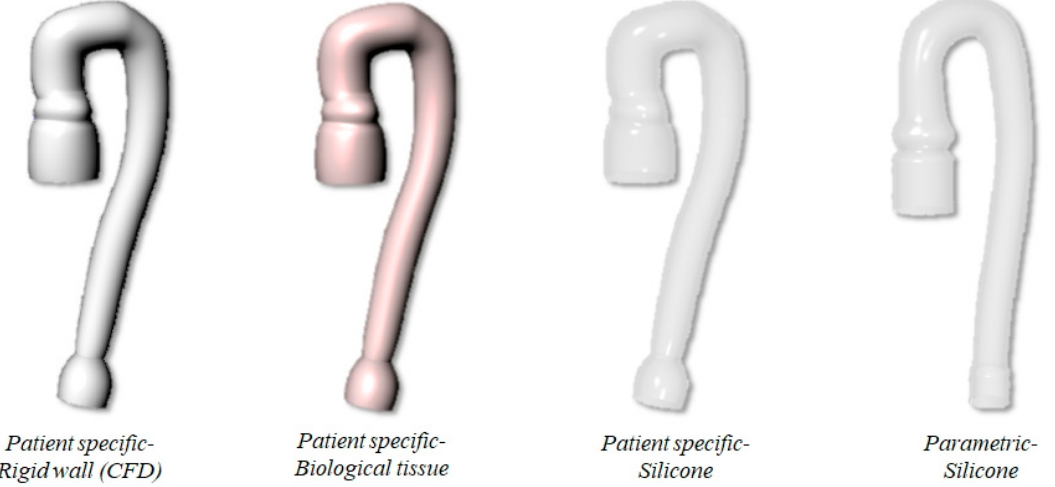
Figure 2. Sketch of the four aortic arch models: patient-specific anatomy with rigid wall, biological tissue and silicone, and parametric aorta in silicone.